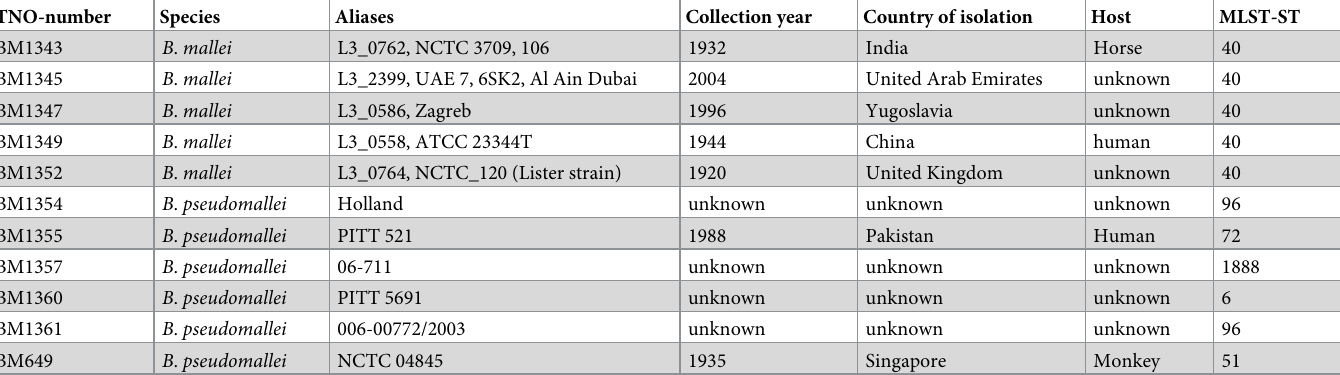
Table 1. Strains included in the